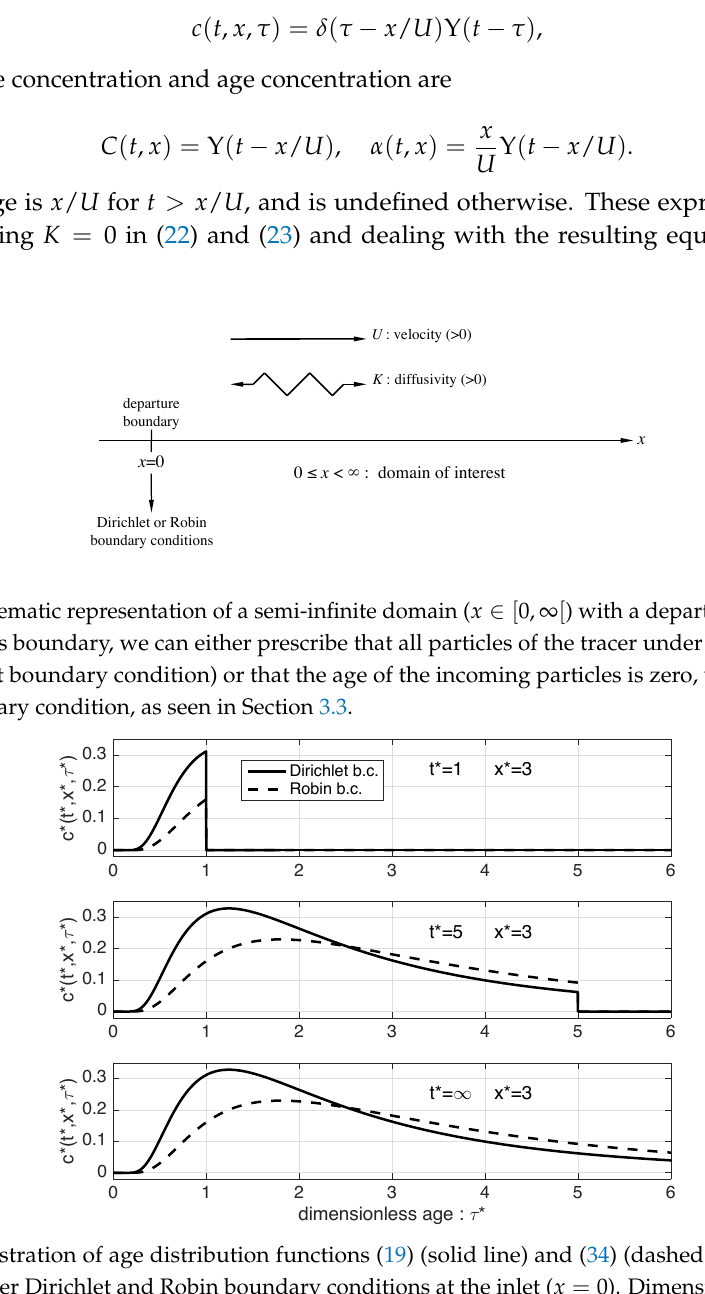
Figure 3. Illustration of age distribution functions (19) (solid line) and (34) (dashed line), which are obtained under Dirichlet and Robin boundary conditions at the inlet ( x = 0). Dimensionless variables are used. They are identified by asterisks and are defined as follows: t ∗ = U 2 t / K , x ∗ = Ux / K , τ ∗ = U 2 τ / K and c ∗ = Kc / U 2 (see Appendix B). The dimensionless age distribution functions are plotted at x ∗ = 3 as functions of the age at different